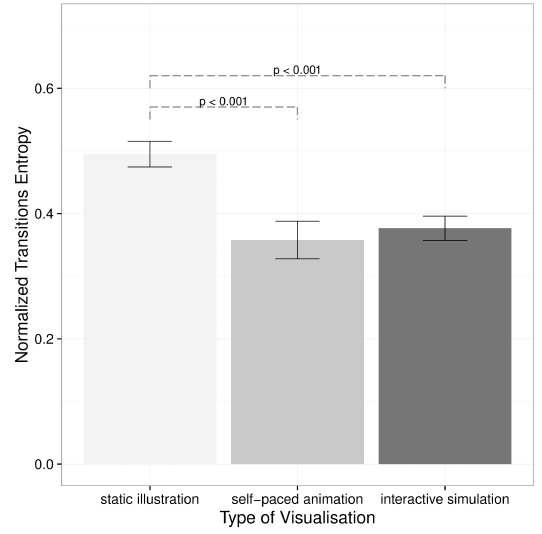
Figure 5. Mean empirical transition matrix entropy dependent on visualization type. The whiskers represents